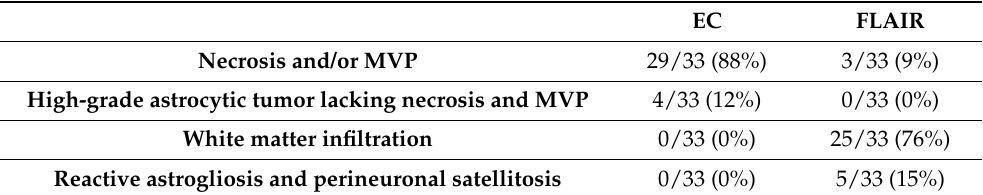
Table 1. Differential distribution of the histological features between EC and FLAIR